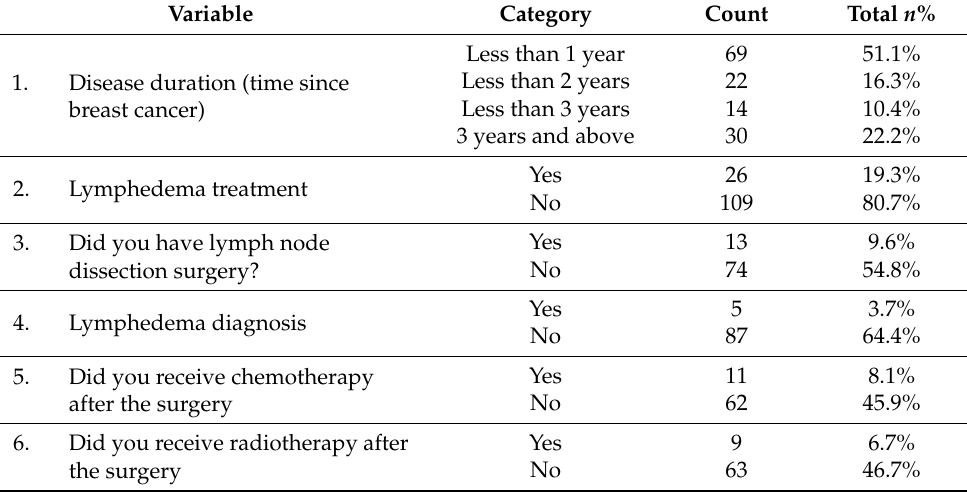
Table 3. Percentage and frequency of basic medical history of breast cancer ( n =